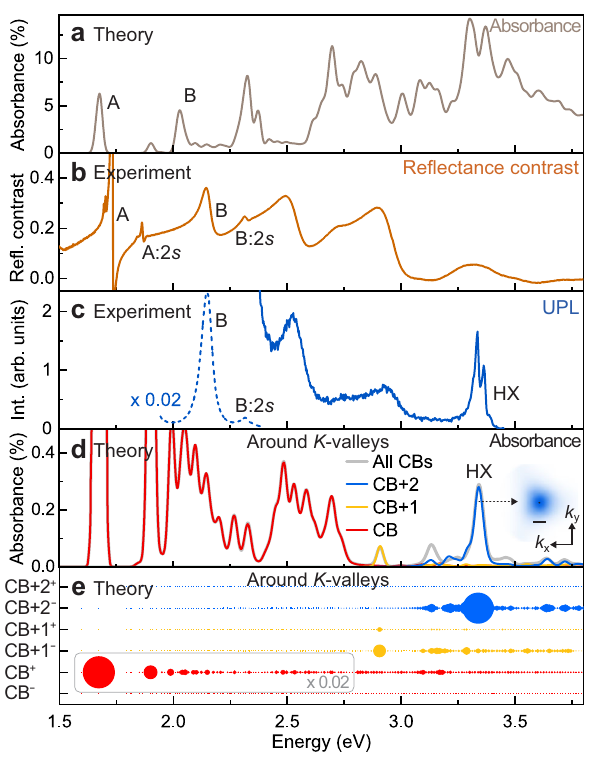
Fig. 4 Identi fi cation of the bound HX in ab initio GW -BSE calculations. a Calculated absorbance spectrum of bare monolayer WSe 2 , accounting for transitions over the entire Brillouin zone. The dominant low-energy excitonic transitions are indicated. b Experimental re fl ectance contrast of monolayer WSe 2 encapsulated by hBN on a sapphire substrate at 5 K. c UPL spectrum (solid line) measured under resonant pumping of the A-exciton. The dashed line shows the same spectrum multiplied by 0.02 at the corresponding energy range. d The calculated absorbance spectrum of bare monolayer WSe 2 , restricted to transitions around the K -points (within 6% of the Brillouin-zone area) from the topmost VB + to only the lower conduction bands (CB, red), only the CB + 1 bands (yellow), only the CB + 2 bands (blue), or all bands (gray). The HX feature at 3.34 eV appears only when contributions from CB + 2 are included. The inset shows the square of the HX envelope function in reciprocal space centered around K (black dot), with a scale bar of 0.2 A (cid:2) 1 . e Contributions of the different spin-split conduction bands to the excitonic optical strength of the different peaks in ( d ), indicated by the size of the disk area. The dominant contribution to HX comes from transitions from the VB + to the negative-mass band CB + 2 − . The disk area within the gray box is rescaled by a factor of